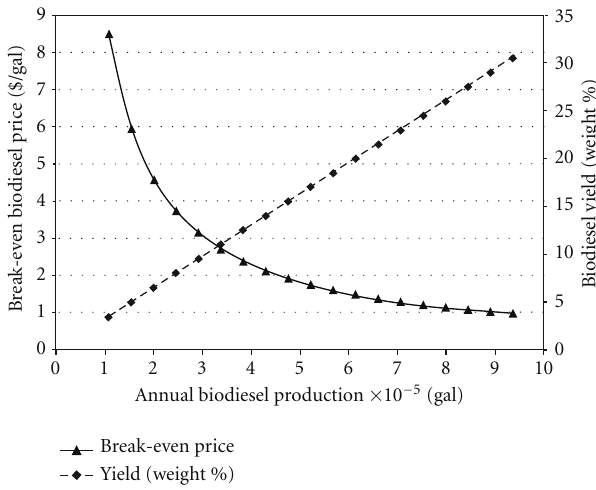
Figure 4: Influence of yield on the break-even price of biodiesel from wet activated sludge